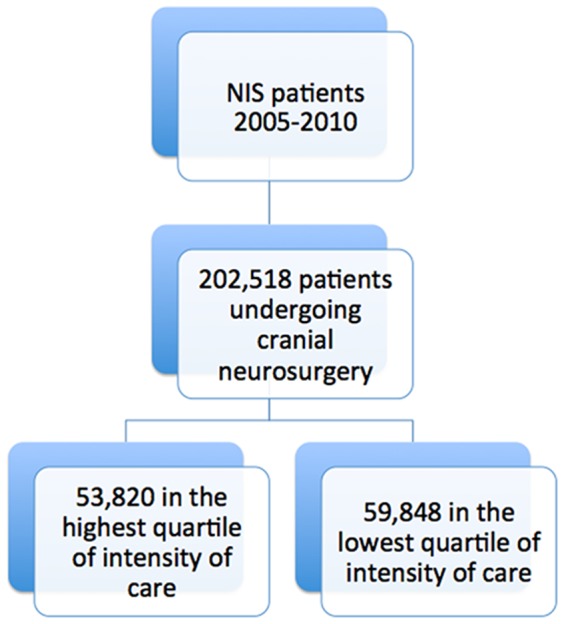
Cohort selection for the study.